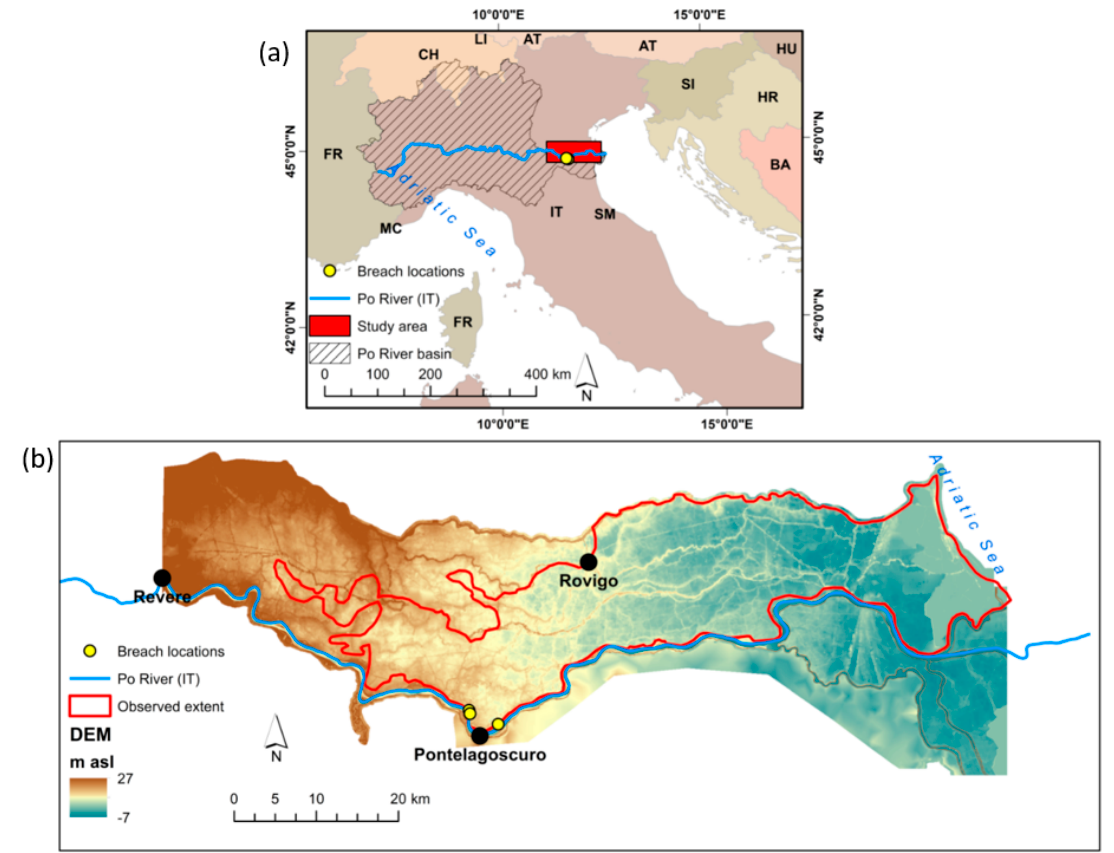
Figure 5. Polesine flood study area ( a ). Study area extent, the outline of the surveyed flood extent, breaches and gauging station locations ( b ).